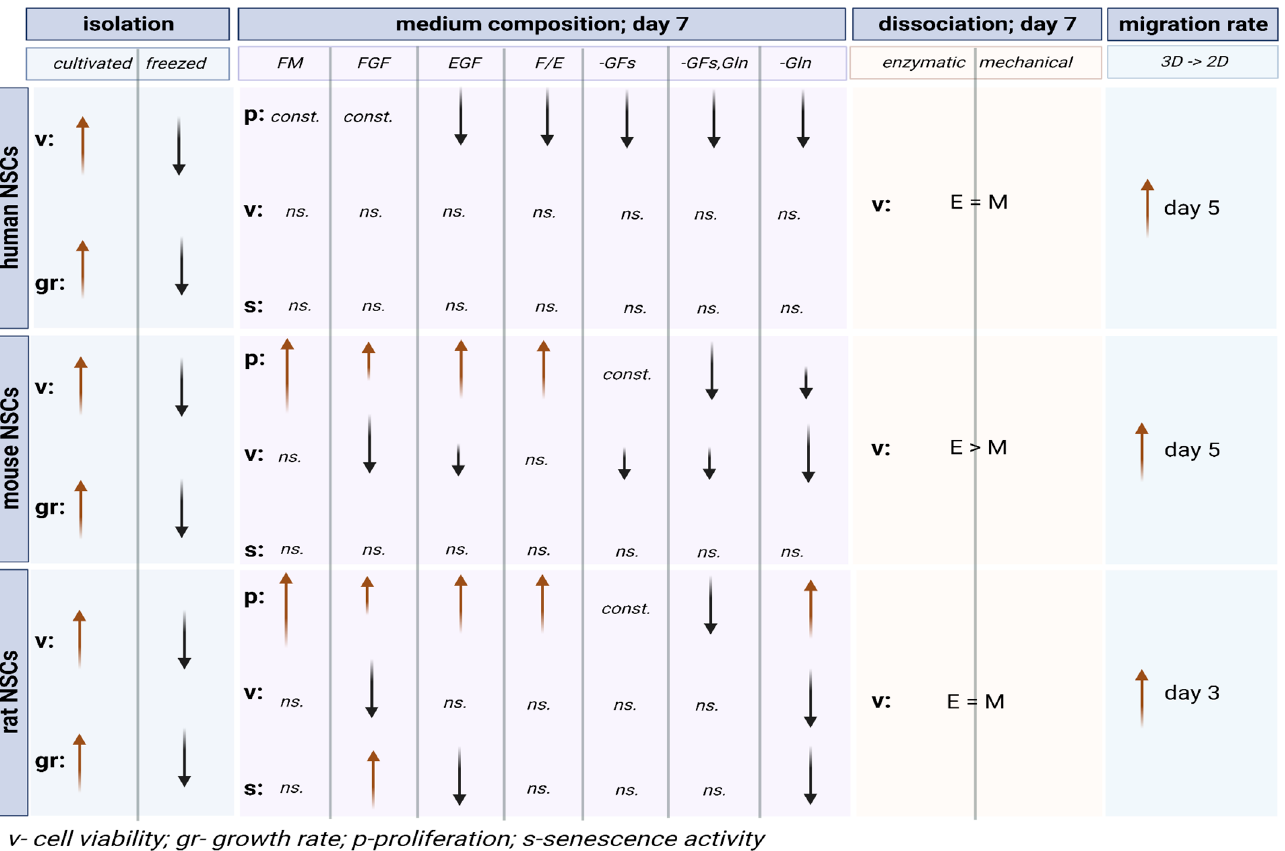
Figure 16. The summary of selected inter-species variability in different culture conditions.